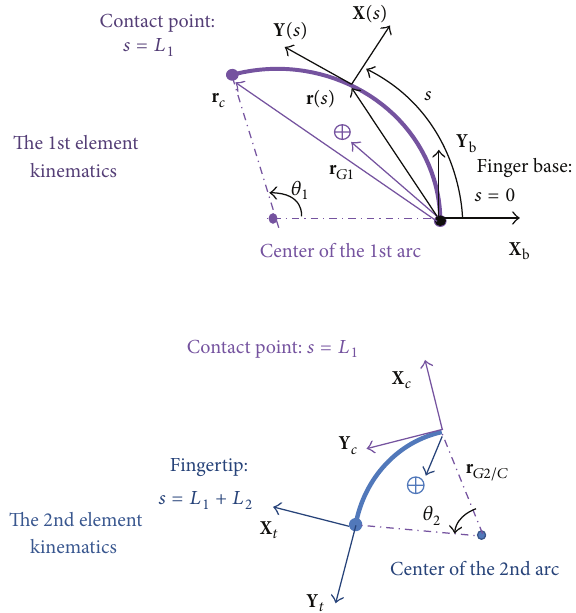
Thus, the backbone is a two-degree-of-freedom system, with generalized variables 𝜃 1 and 𝜃 2